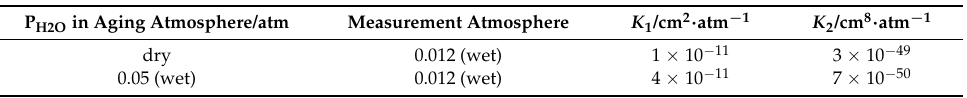
Table 2. Estimated equilibrium constants of oxygen adsorption for O − ( K 1 ) and O 2 − ( K 2 ) at 350 ◦ C in wet air. The device was aged under dry and humid